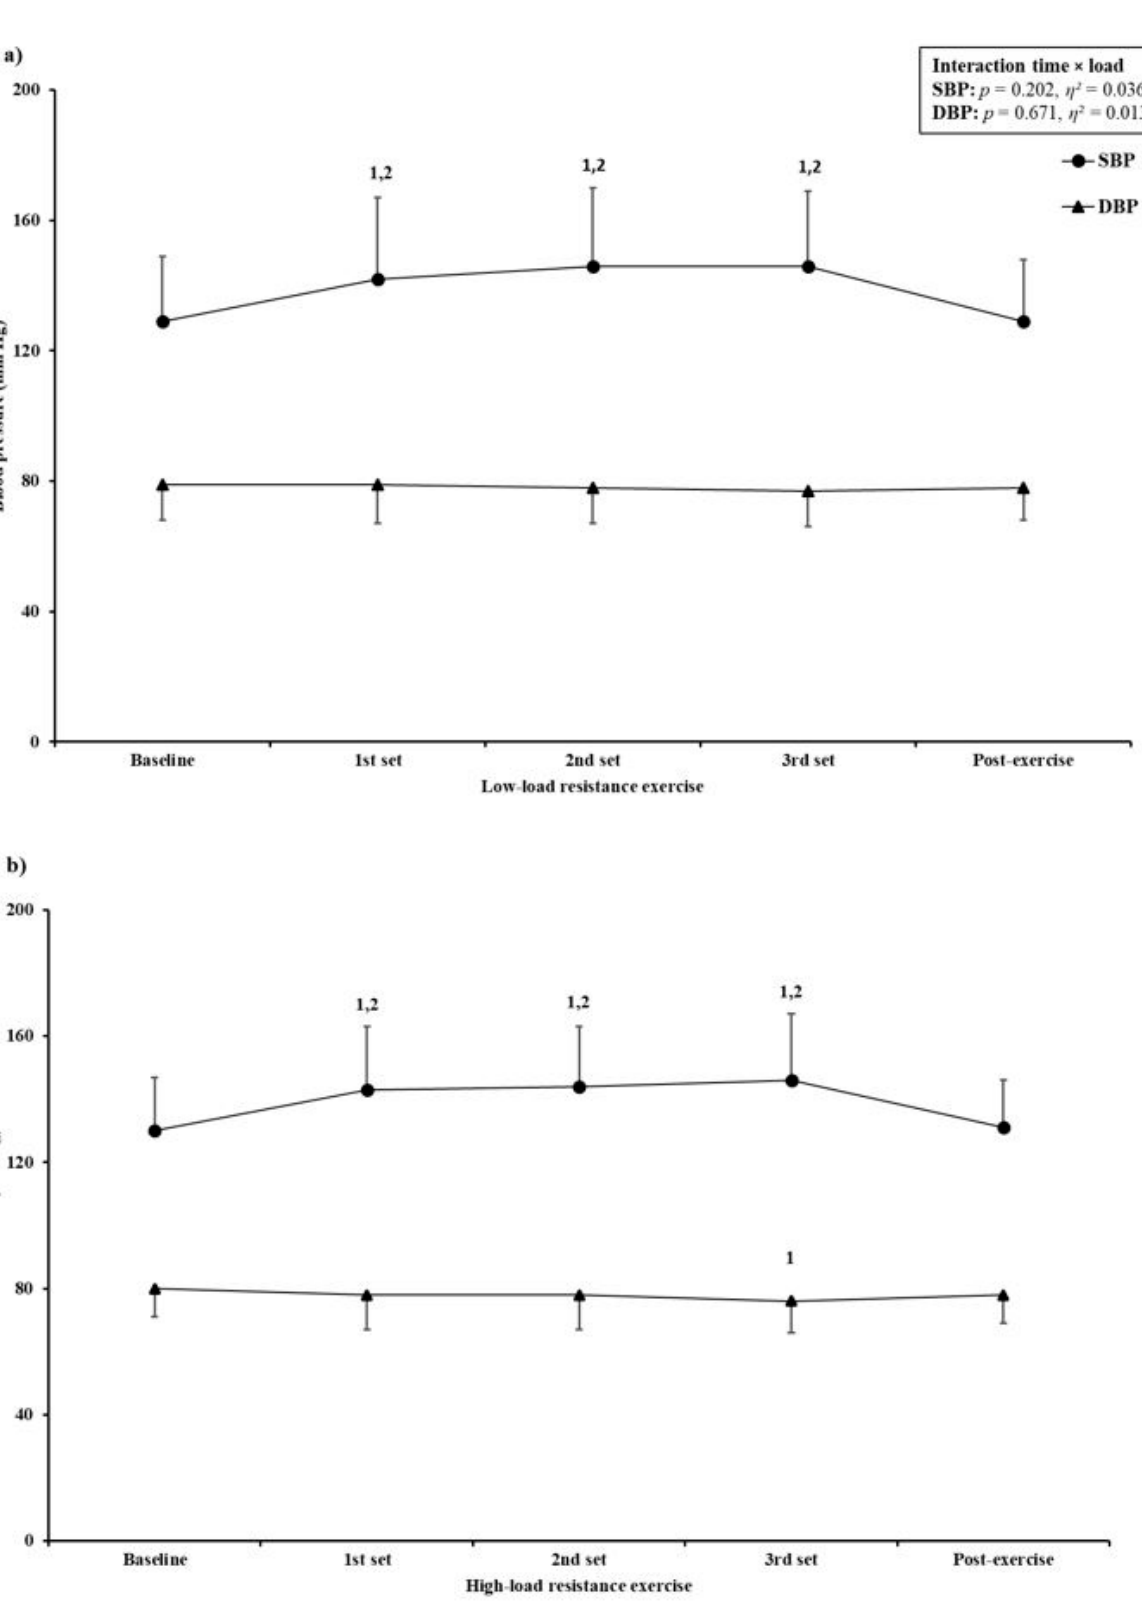
Figure 2. Blood pressure response to ( a ) low-load resistance exercise and ( b ) high-load resistance exercise. SBP: systolic blood pressure; DBP: diastolic blood pressure; η ²: partial eta squared. Data are expressed as mean (dots and triangles) and SD (vertical lines). 1 = significantly different from baseline; 2 = significantly different from post-exercise.